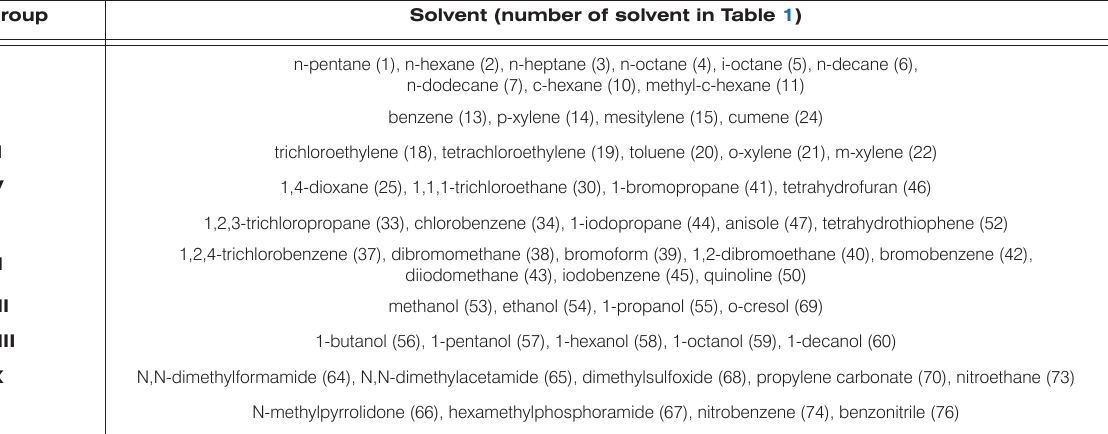
Table 2. The first training set for PNN. Group Solvent (number of solvent in Table 1)